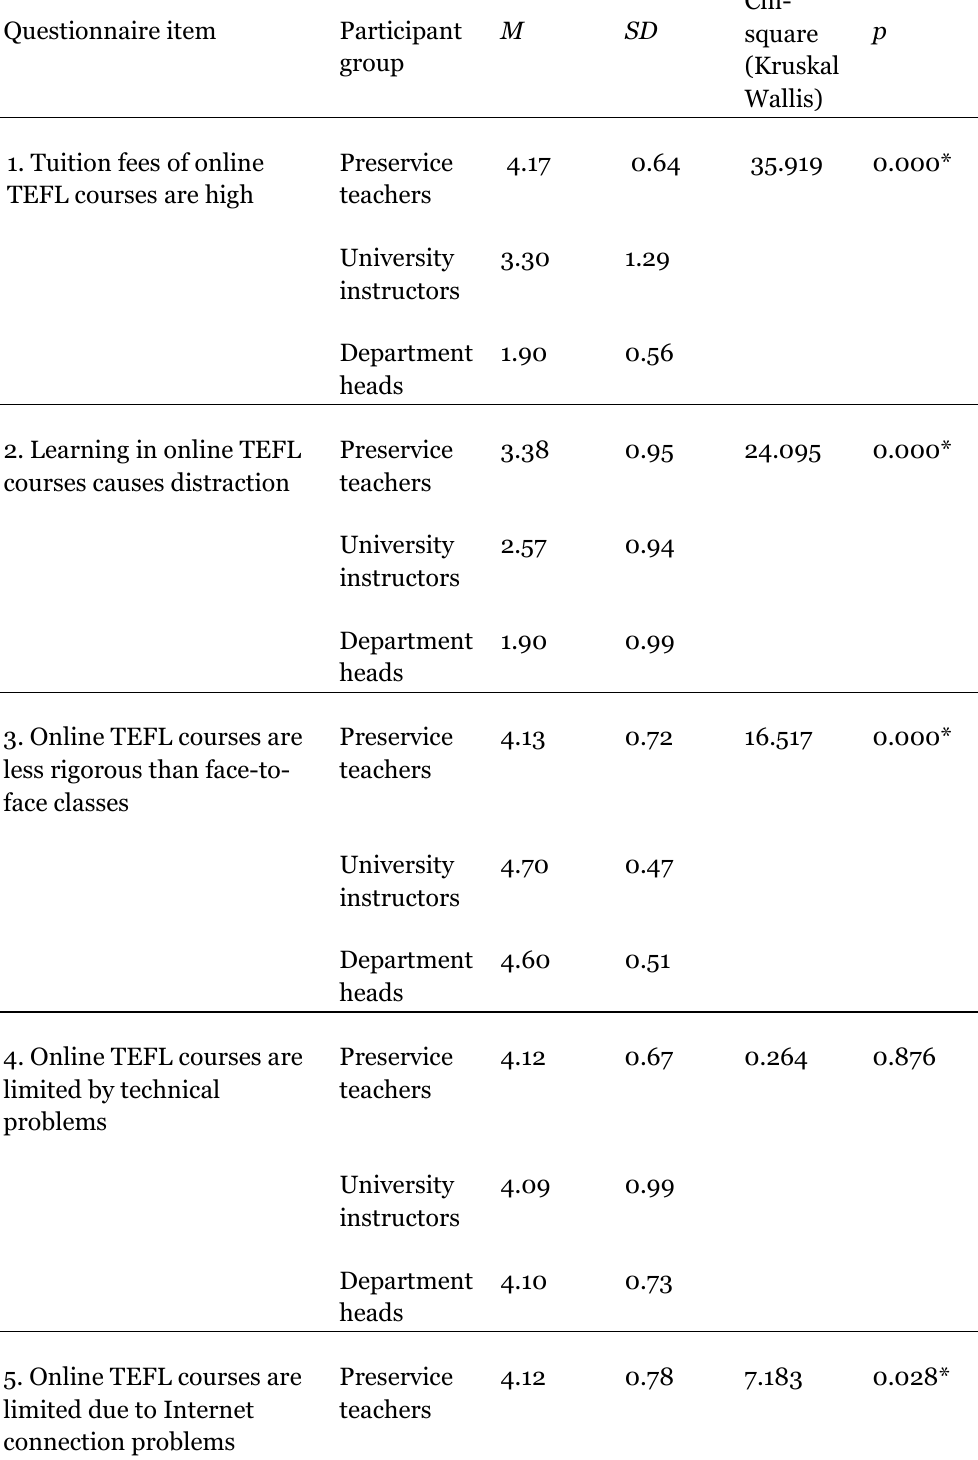
Table 2 Questionnaire Results on the Challenges of Online TEFL Courses